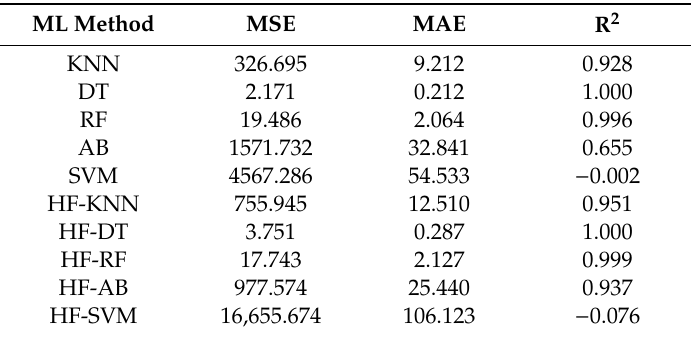
Table 10. Latitude regression results of training data.